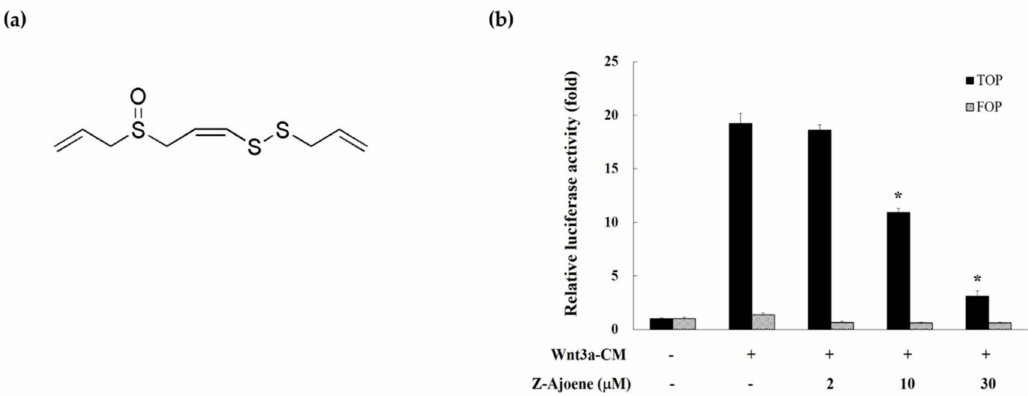
Figure 1. E ff ects of Z-ajoene on β -catenin response transcriptional activity in Wnt3a-activated HEK293 reporter cells. ( a ) chemical structure of Z-ajoene; ( b ) HEK293 reporter (TOPFlash) cells and control (FOPFlash) cells were incubated with Z-ajoene in the presence of Wnt3a-CM. After 15 h, luciferase activity was determined and expressed as a relative TOPFlash activity compared to vehicle-treated cells. The values are presented as the mean ± S.D. of three independent experiments. * p < 0.05 indicates